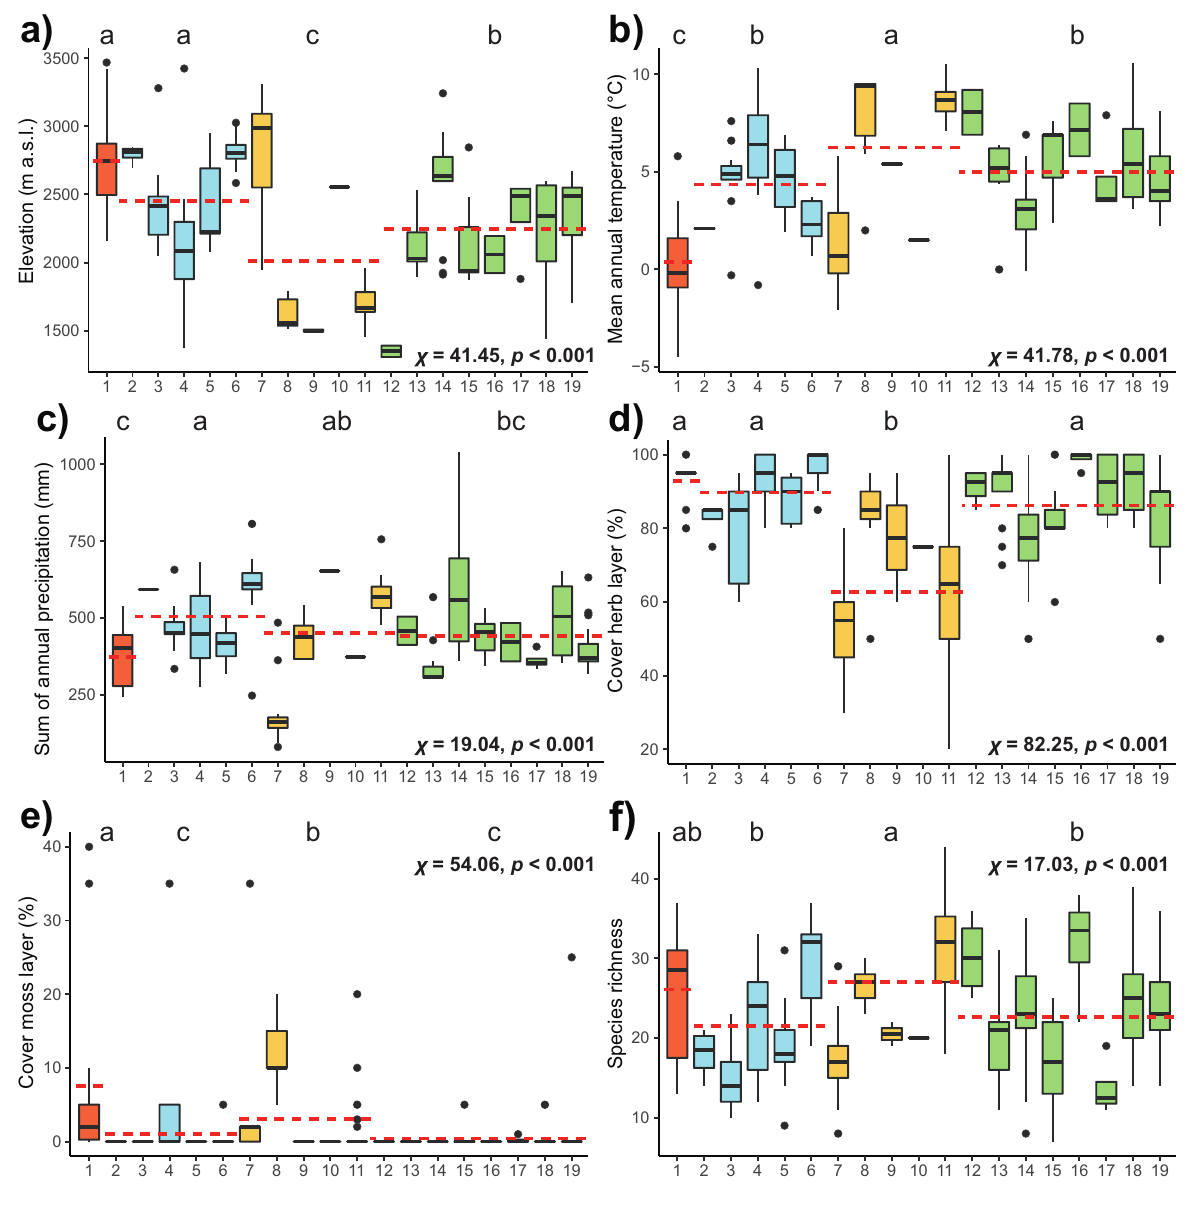
Figure 5. Boxplots showing median (line), quartiles, outliers and the range of (a) elevation, (b) mean annual tem- perature, (c) sum of annual precipitation, (d) cover of herb layer, (e) cover of moss layer and (f) species richness for particular syntaxonomic units. Red line indicates mean values of alliances. The values of χ 2 and p for statistical tests for vegetation groups are shown. Different letters indicate significant differences among the alliances. The abbre- viations of the syntaxonomic units are explained in the Syntaxonomic